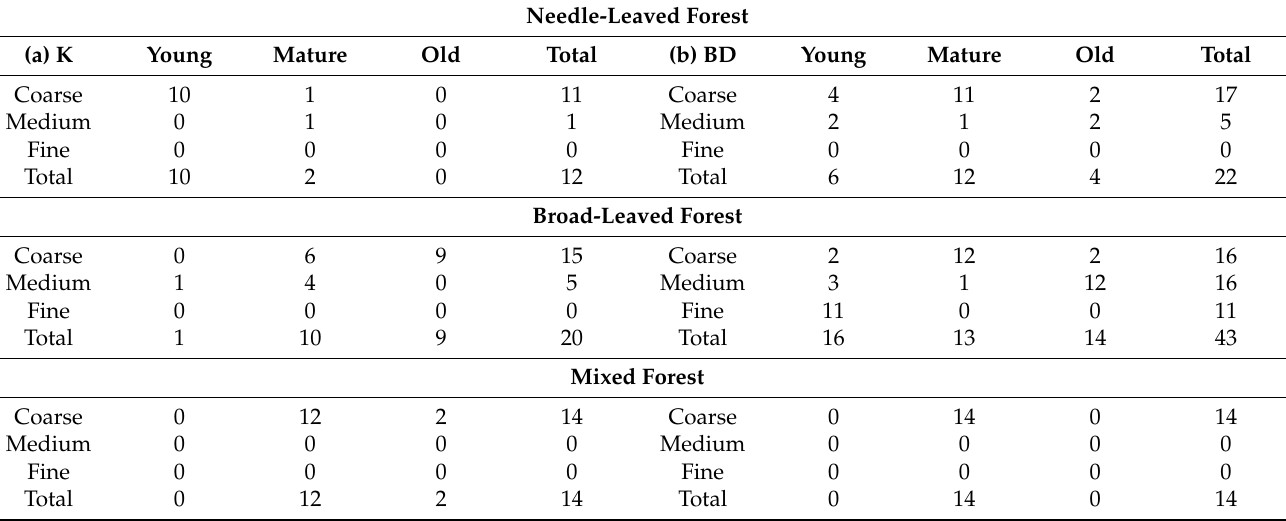
Table 1. Classification of values found in the reviewed literature filtered by forest type as main field and further divisions by soil texture and tree age, which were defined by this study. The left side of the table (a) corresponds to the hydraulic conductivity (K) and right side (b) refers to the soil bulk density (BD). All values are measurements between 0 and 30 cm soil